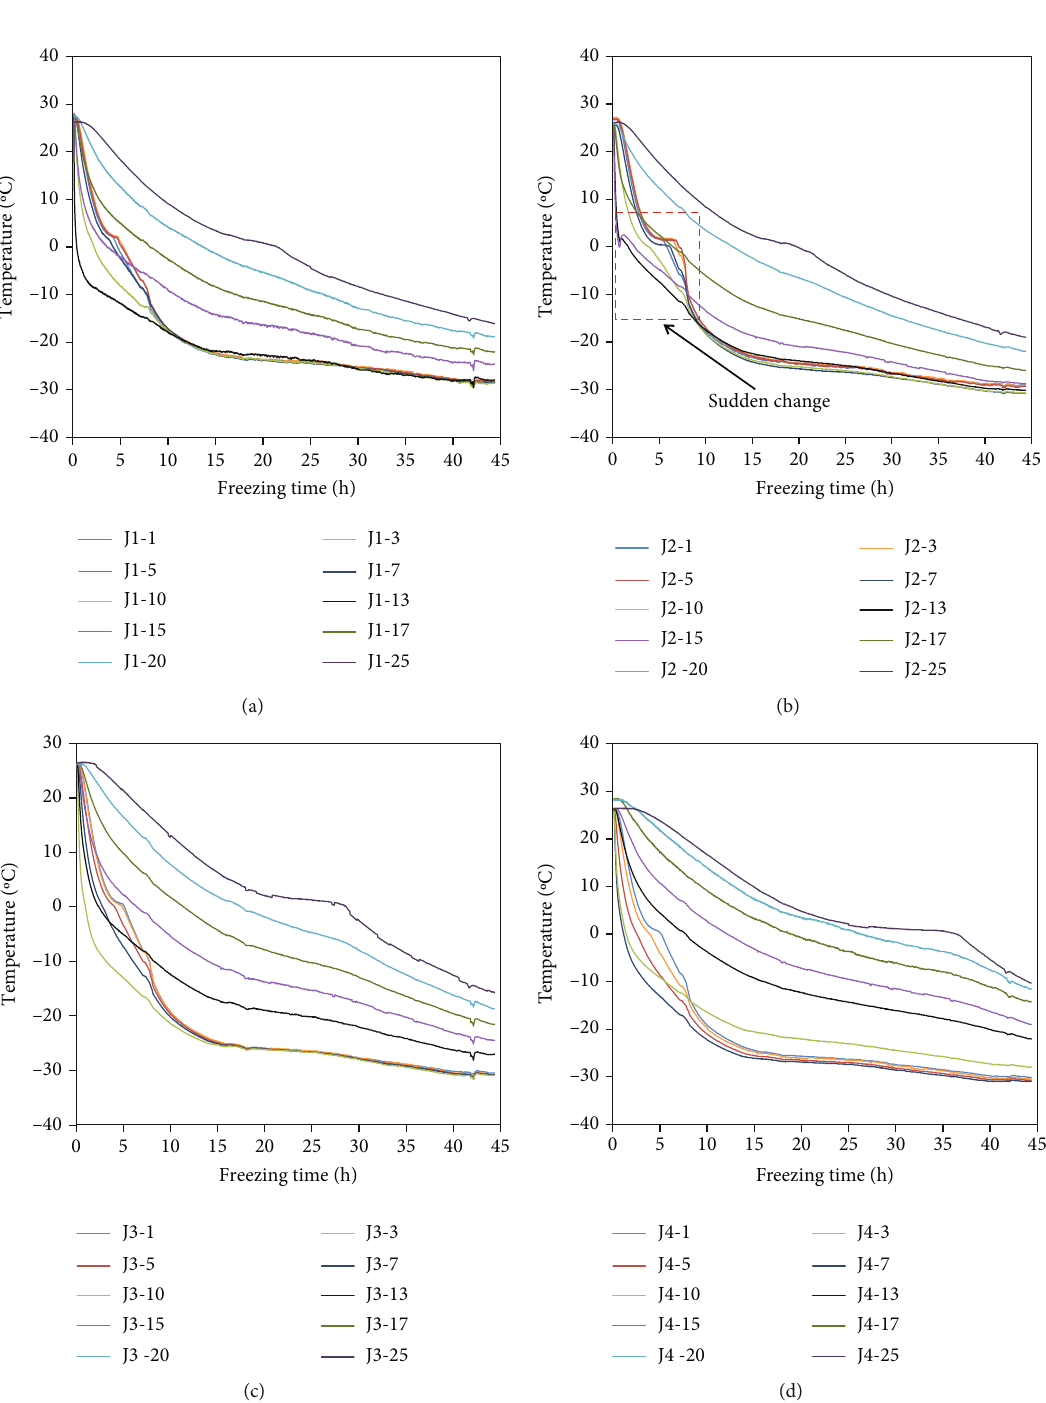
Figure 8: Evolution of the radial temperature fi eld in monitoring section D1: (a) at arch crown-J1, (b) at arch baseline-J2, (c) at wall corner- J3, and (d) at base plate-